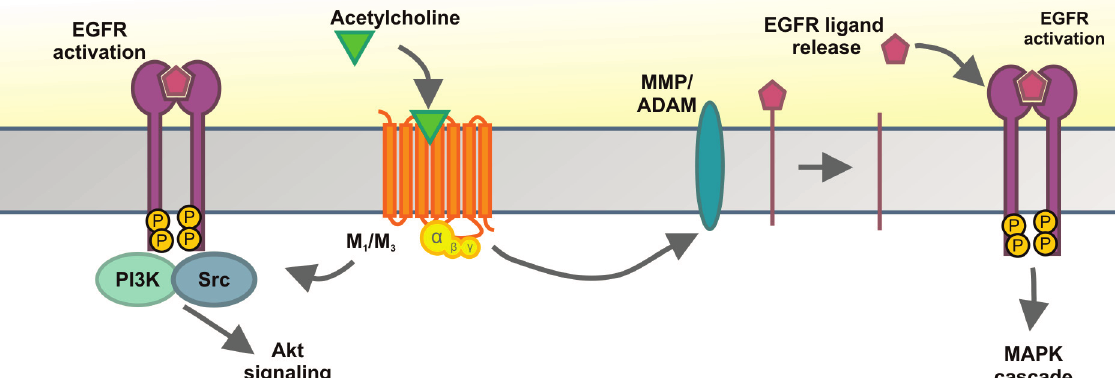
Figure 8. Cholinergic EGFR transactivation in HaCaT cells. Stimulation of mAChRs results in MMP activation and release of an EGF family ligand that activates the EGFR. Downstream thereof, MAP kinase ERK and the Akt kinase are activated, but ERK and Akt activation proceed through different pathways, since Src kinases and PI3K are required for Akt activation but are dispensable for ERK activation by cholinergic